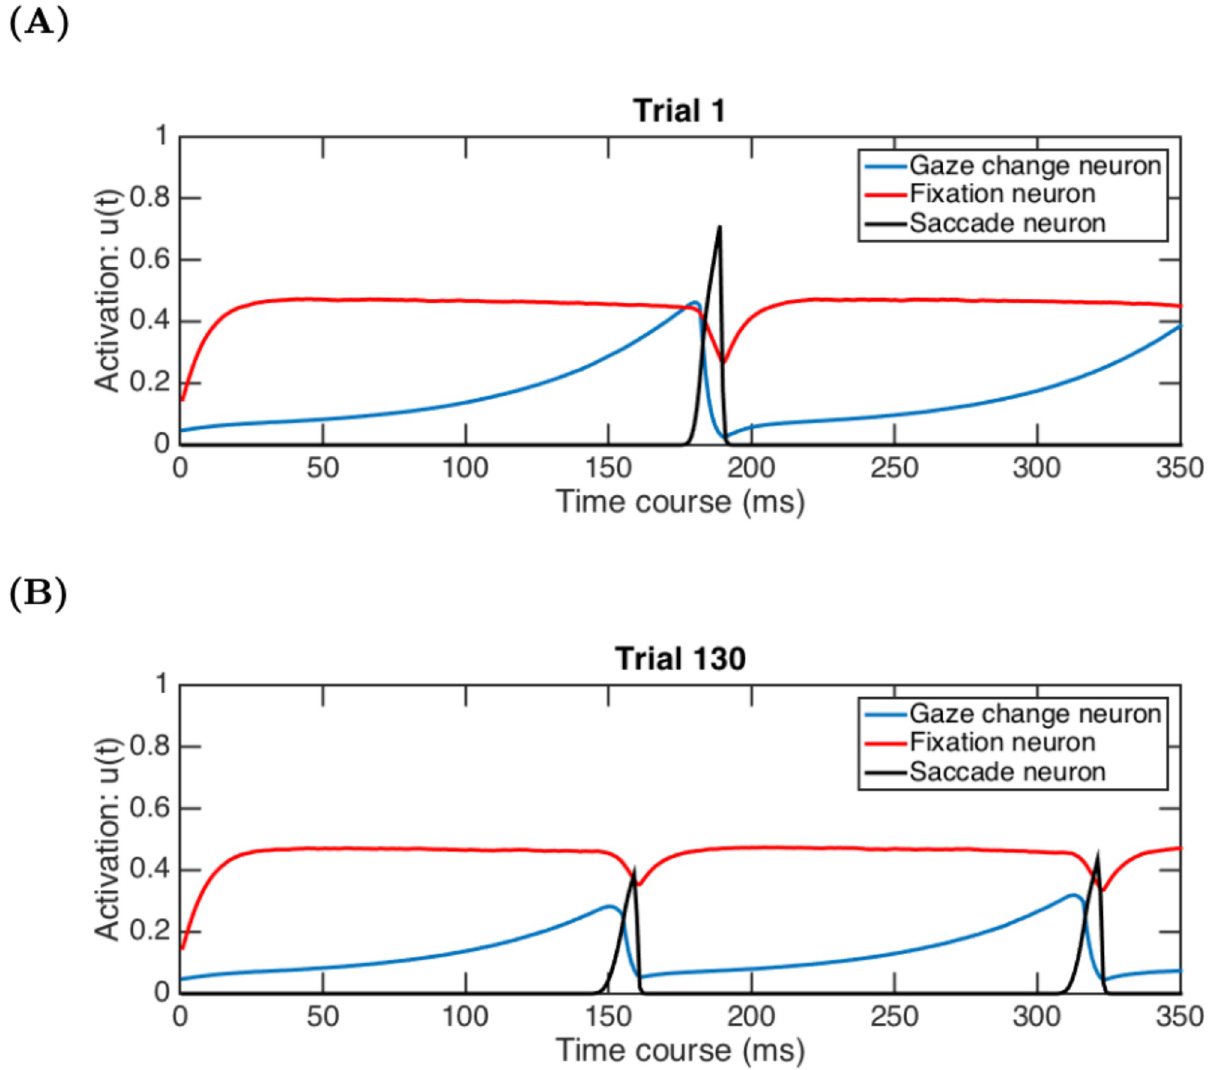
Fig 3. Isolated parameter influences on model. In each of the six figures a comparison of the model’s behaviour is presented at three different levels of the parameters. Each set of parameters is chosen from the closest models available when restricted to the range set by the lowest and highest observed in the best fits of individuals in Experiment 1. In each case, one free parameter is compared while the other two parameters are held to the overall medians observed within that same range. A) Model accuracy over three levels, low, medium and high, of Learning Rate ([2.5 × 10 − 6 , 1.1 × 10 − 5 , 1.65 × 10 − 5 ]), when Fixation Impatience is 1.7 and Trial Impatience is 1.8. B) Model fixation counts over three levels, low, medium and high, of Trial Impatience ([1.6, 1.8, 2.05]), when Learning Rate is 1.1 × 10 − 5 and Fixation Impatience is 1.5. C) Model fixation durations over three levels, low, medium and high, of Fixation Impatience ([1.5, 1.7, 1.9]), when Learning Rate is 1.1 × 10 − 5 and Trial Impatience is 1.8. D) Model accuracy over three levels, low, medium and high, of Trial Impatience ([1.6, 1.8, 2.05]), when Fixation Impatience is 1.7 and Learning Rate is 7 × 10 − 6 . E) Model feature fixation probability over three levels, low, medium and high, of Trial Impatience ([1.6, 1.8, 2.05]), Fixation Impatience is 1.7 and Learning Rate is 1.1 × 10 − 5 . F) Model feature fixation durations over three levels, low, medium and high, of Learning Rate ([2.5 × 10 − 6 , 1.1 × 10 − 5 , 1.65 × 10 − 5 ]), Fixation Impatience is 1.7 and Trial Impatience is 1.8. Shading represents standard deviations of the model for that level of